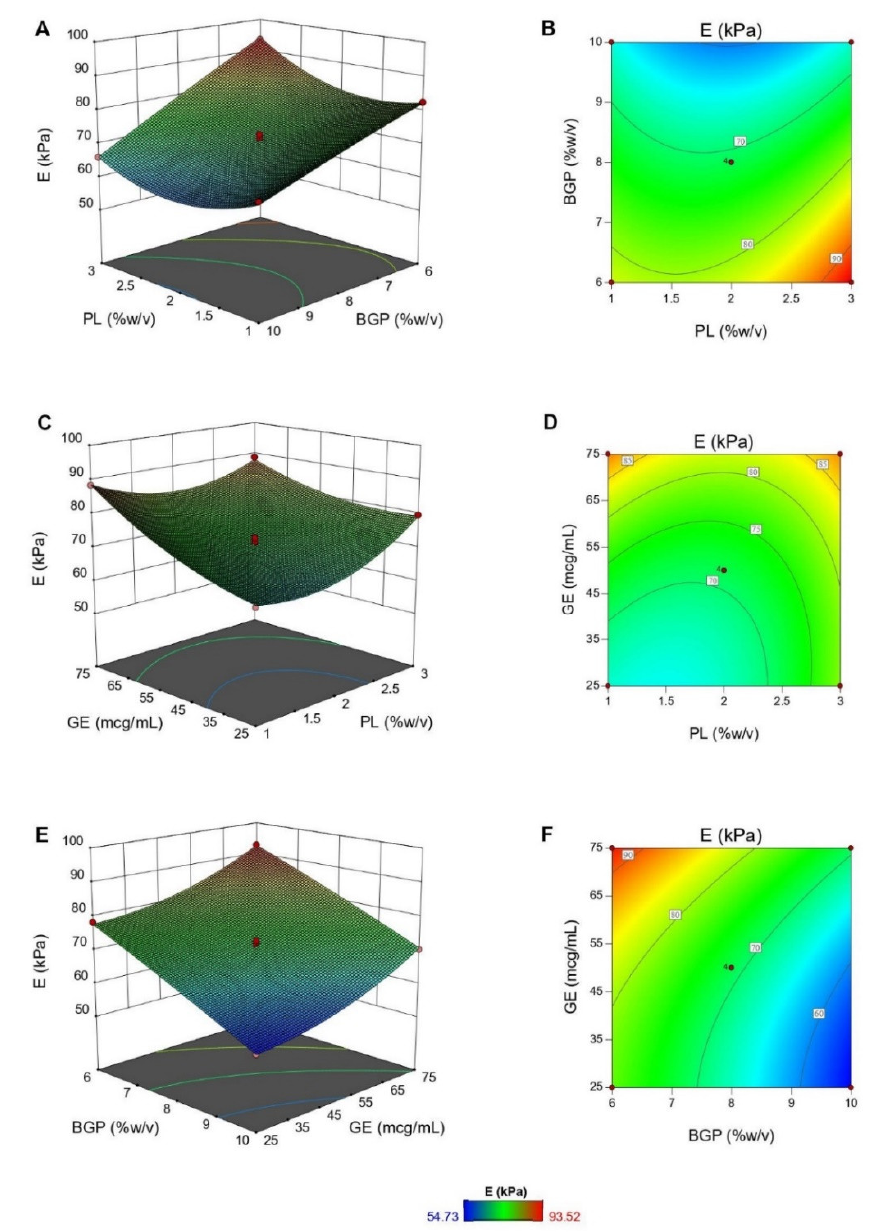
Figure 4. The response surface plots showing the interaction e ff ects of PL and BGP ( A ), PL and GE ( C ), and BGP and GE ( E ) on Young’s modulus ( E ), together with the corresponding contour plots ( B , D , F ). Figure 5 demonstrates the plots for the relationship between independent variables and